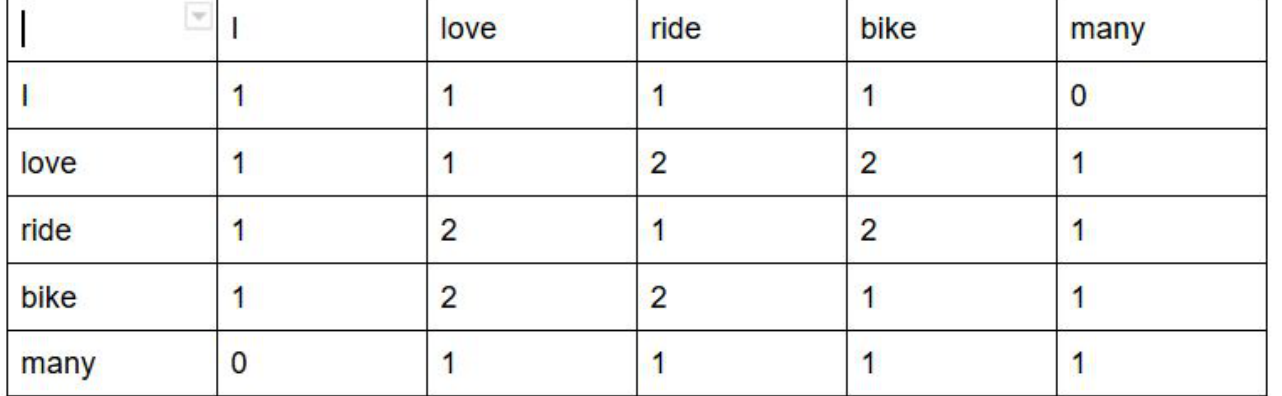
Figure 5. A sample co-occurrence